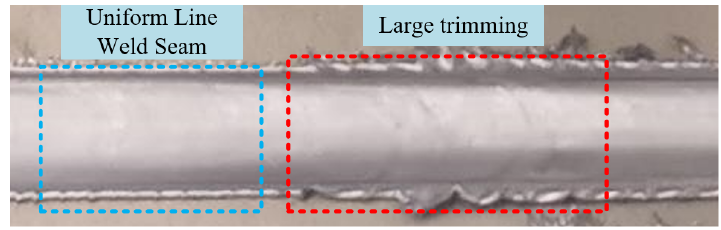
Figure 1. Two types of weld seams.